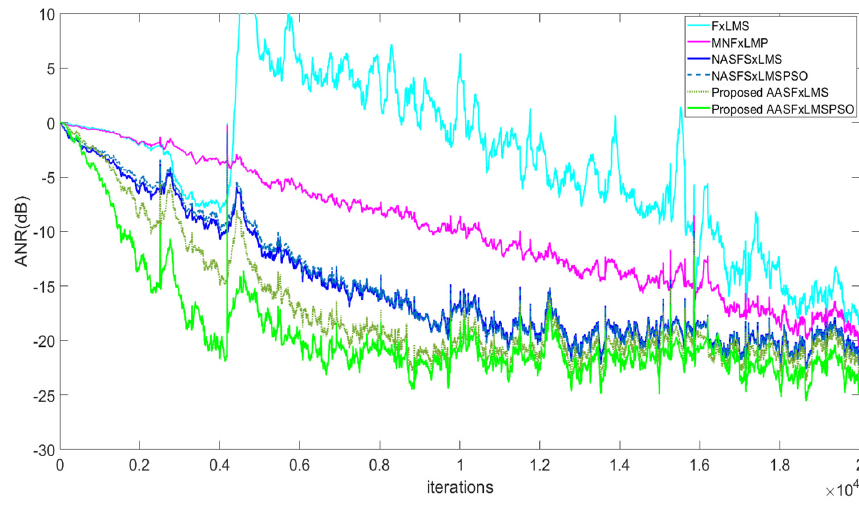
Figure 8. The noise reduction effect of the S α S distributed pulse noise, where α = 1.5. Example 3: S α S pulse noise with α = 1.3 is used as the reference signal. The noise